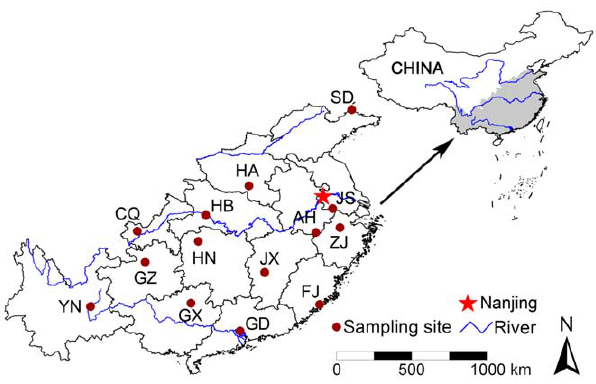
Figure 1. Provincial outline map of our research area in China, indicating the location of the 14 sampling sites as well as the three major rivers in the area (from north to south, Yellow River, Yangtze River, and Pearl River). The two-letter codes correspond to those listed in Table 1. The city Nanjing was marked with a solid star to represent the first reported PWN outbreak area in mainland China.